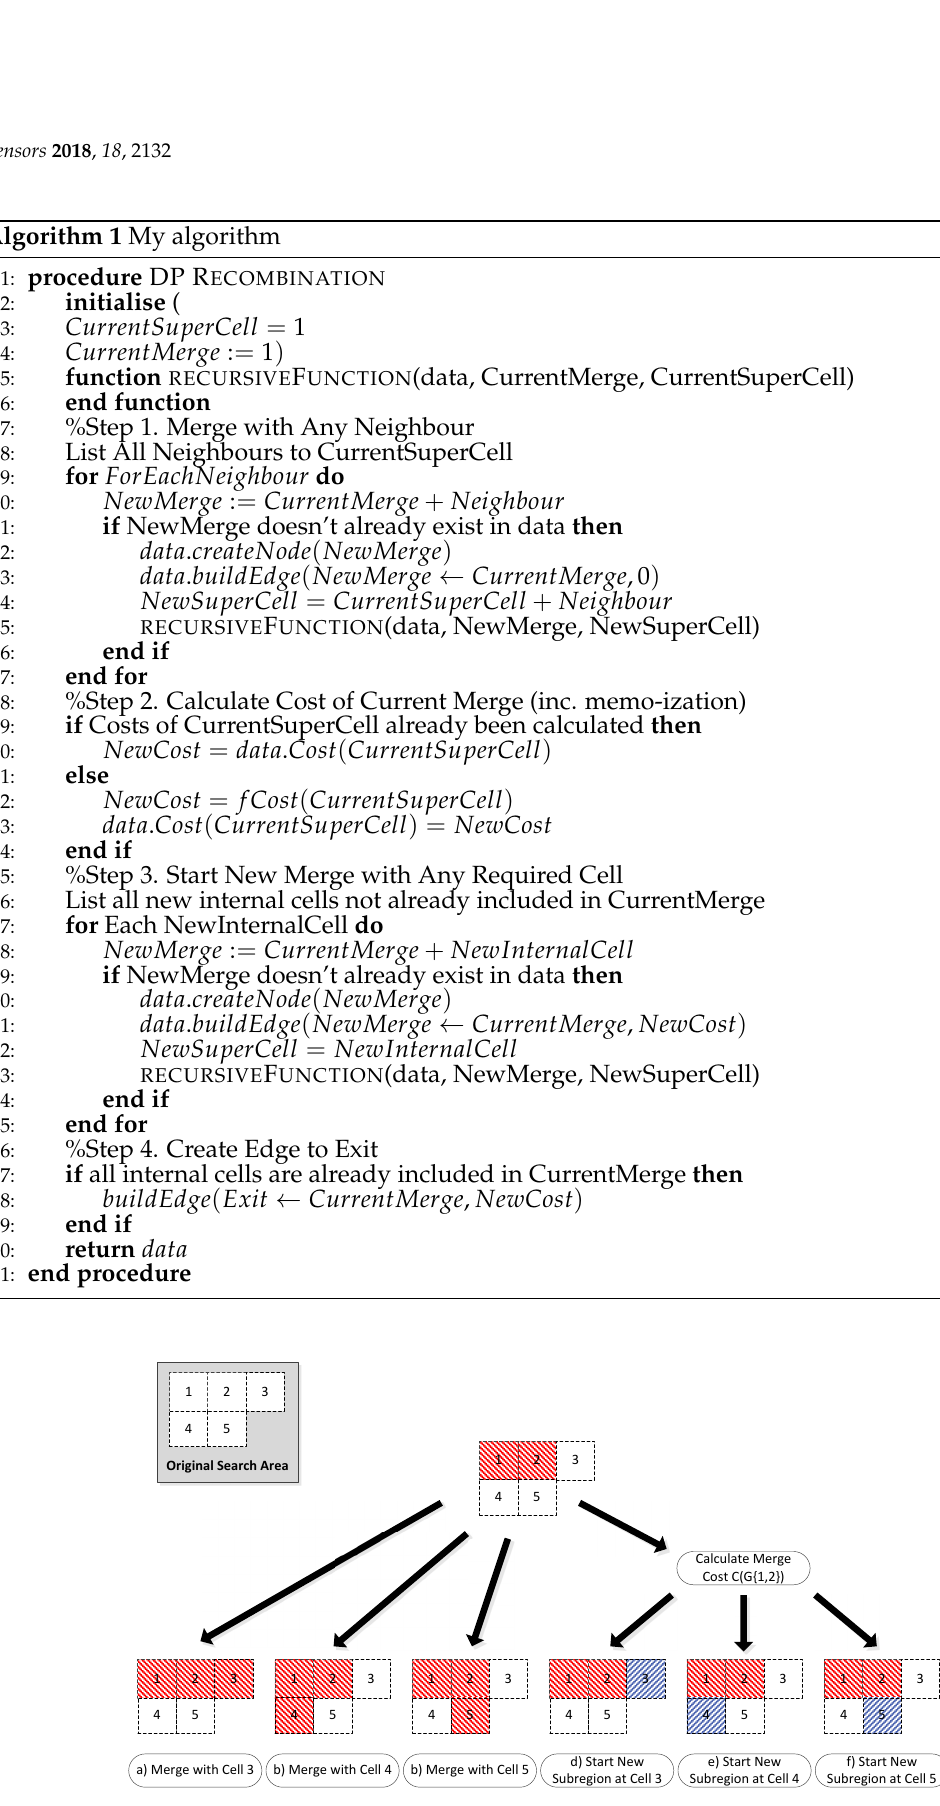
Figure 13. “Bottom Up” Dynamic Programming Solution Formulation—showing a single cell merge step, where each adjacent cell is either merged or a new subregion is